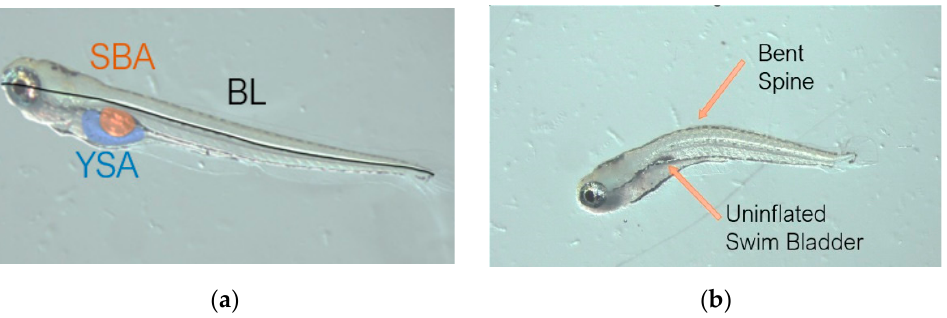
Figure 1. Examples of morphometric measurements taken from 5 dpf; BL = body length, SBA = swim bladder area; YSA = yolk sac length. ( a ) Example from control group showing normal development. ( b ) Example from binary mixture T5 (see Table 1 for measured concentrations of PFOS and 6:2 FTS), showing differences in SBA and